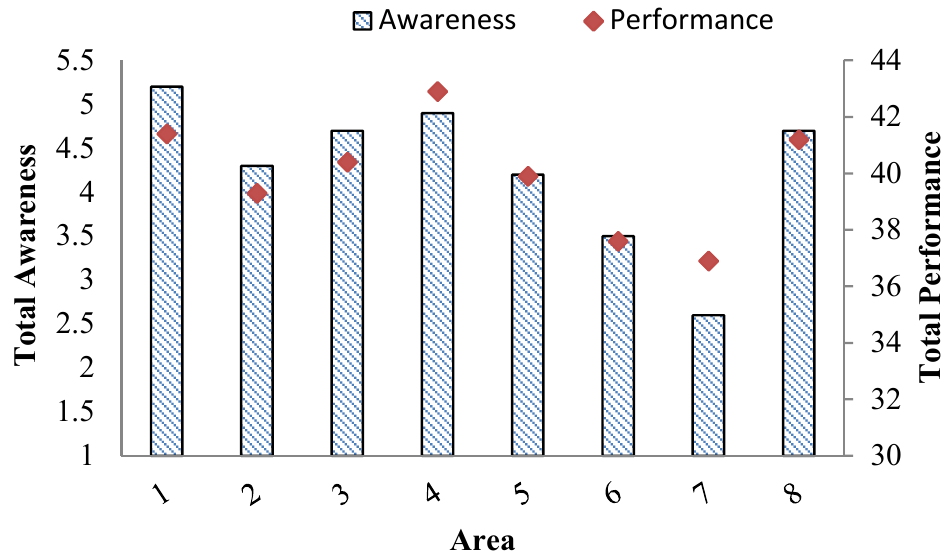
Figure 2. Citizens’ level of awareness and